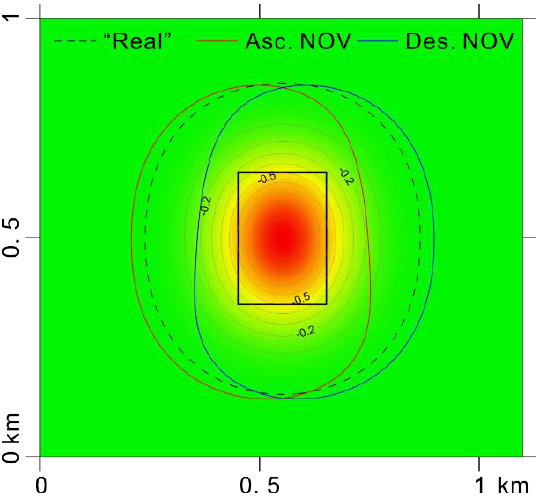
Figure 11. Subsidence boundaries delimitated with the ascending (red line) and descending (blue line) NOV-estimated subsidence. The black dashed line denotes the “real” subsidence boundary. The base map is the contour of the simulated mining subsidence.